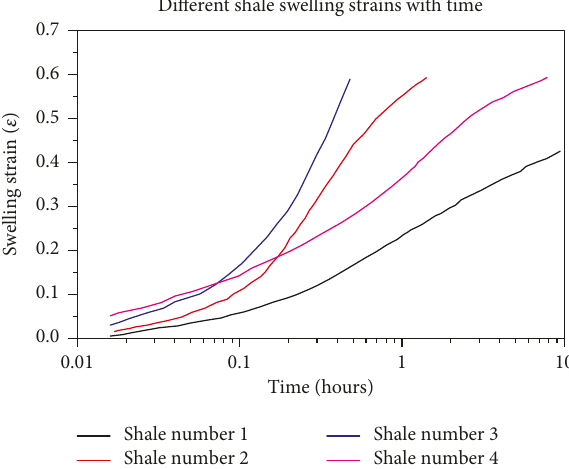
Figure 13: The relationship between swelling strain and time for four di ff erent kinds of shale (modi fi ed from reference [32]). The swelling speed decreases largely with time. Table 3: The fi tting results between swell strain and time. Shale